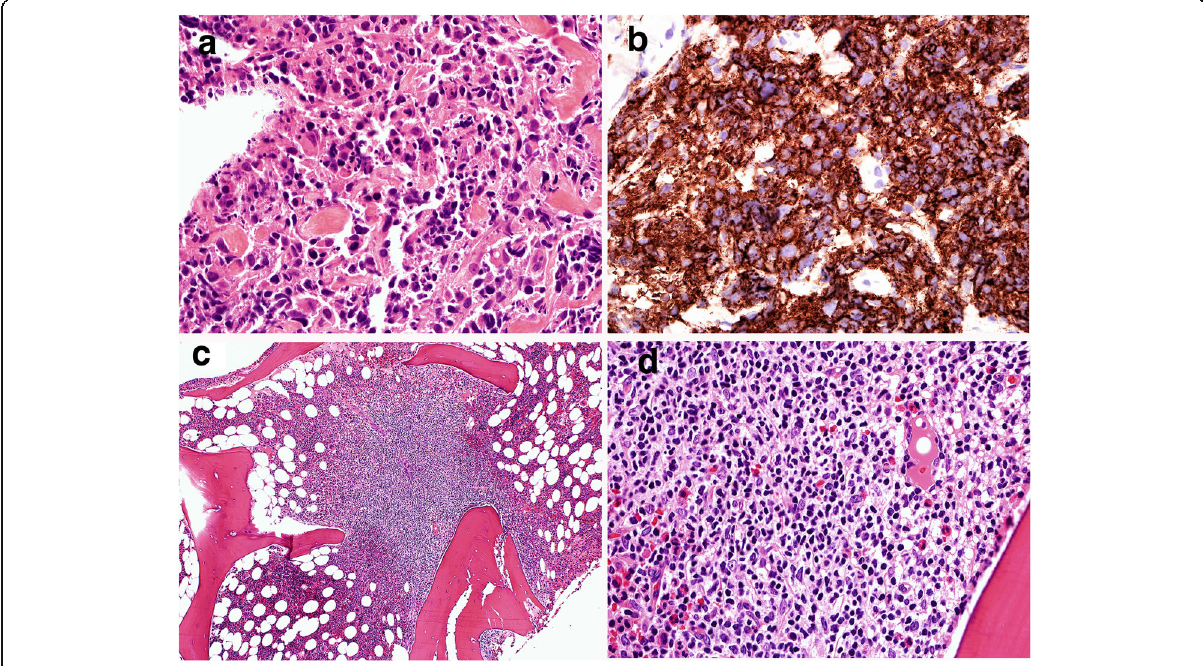
Fig. 2 Diffuse large B-cell lymphoma. A transbronchial biopsy of the lung mass shows a diffuse proliferation of CD20+ large cells with large nuclei, open chromatic, occasional nucleoli associated with frequent apoptotic bodies ( a H&E, 600X; b CD20 IHC, 600X). A bone marrow core biopsy shows an abnormal paratrabecular lymphoid infiltrate comprising of small lymphocytes with elongated nuclei ( c H&E, 200X; d H&E, 600X). Flow cytometric analysis of the bone marrow aspirate (not shown) identified a monotypic, surface lambda light chain-restricted B-cell